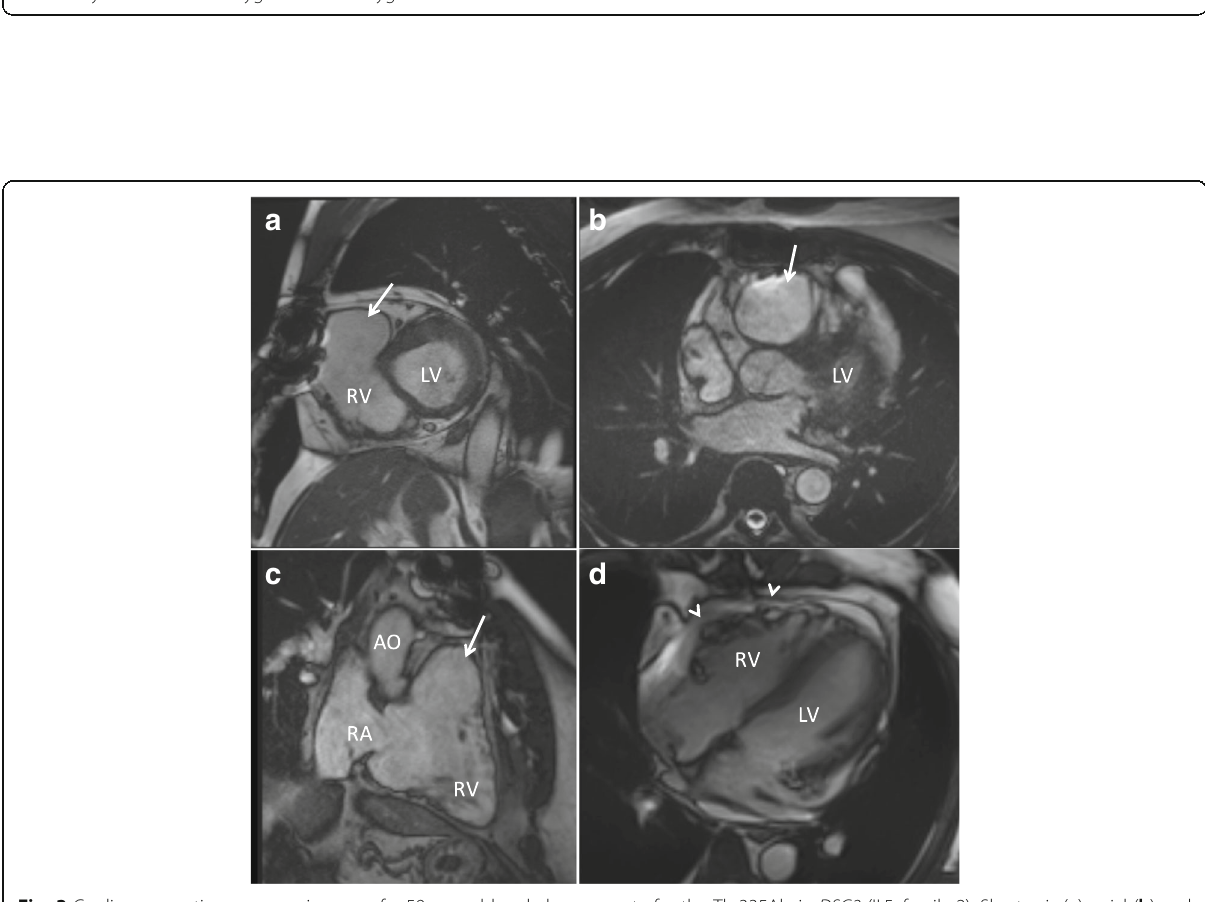
Fig. 2 Pedigrees of the two families affected with the c.1003A > G, p.(Thr335Ala) mutation in DSG2 . Black-filled symbols represent individuals who fulfill the 2010 Task Force Criteria by Marcus et al. [9]. Age of the family members and their genotypes are listed below the symbols. Parents of the affected individuals in family 1 are obligatory carriers of the variant. In family 2, one of them is an obligatory heterozygous carrier, while the other may either be heterozygous or homozygous for the variant